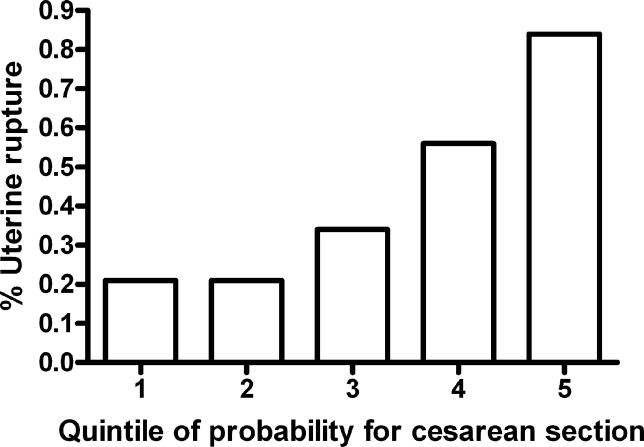
Proportion of Uterine Ruptures in Relation to the Quintile of Predicted Probability of Emergency Cesarean Delivery for the Whole Population
n = 23,286; p < 0.001 (Chi square test for trend).